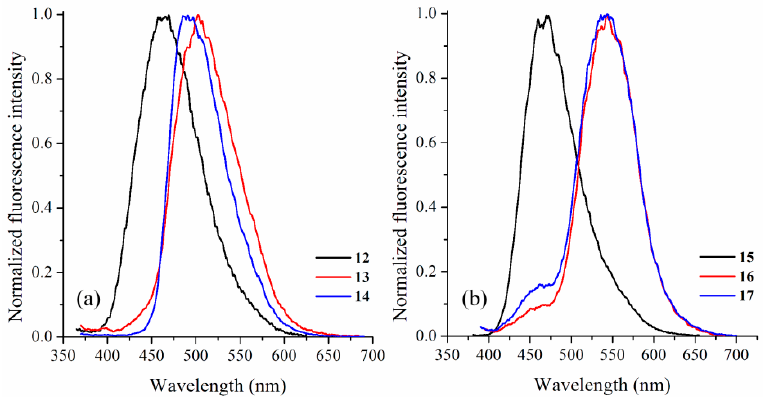
Figure 2. Steady-state fluorescence emission spectra in PBS (pH 7.2) for (approx. 10 − 5 M) of ESIPT fluorescent lipophilic (a) benzoxazoles 12 – 14 and (b) benzothiazoles 15 – 17 .